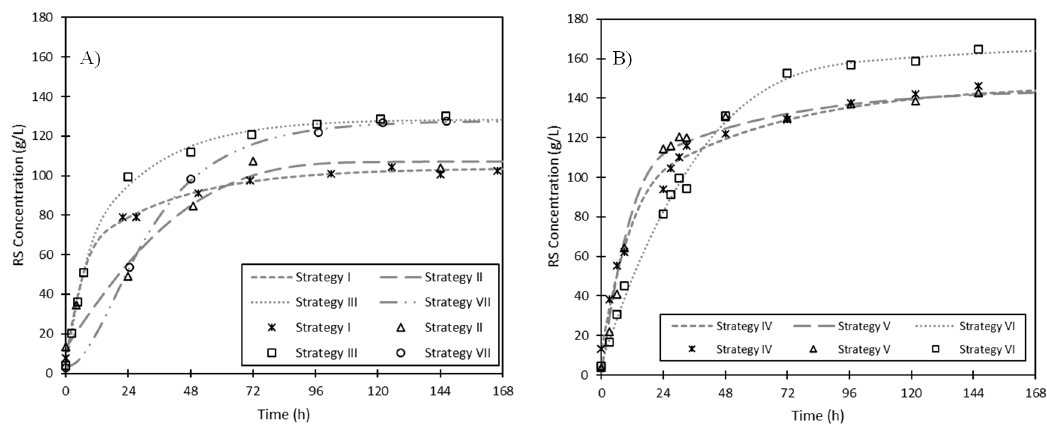
Figure 5. Evolution of RS concentration over hydrolysis time of fresh ESBPPs in 300 mL of citrate ‐ phosphate buffer (pH 5, 0.05 M) at 50 °C with addition of Celluclast ® (2.17 U ∙ g − 1 dried fresh ESBPPs). ( A ) Fed ‐ batch hydrolysis with a total FFR of 15:55. ( B ) Fed ‐ batch hydrolysis with a total FFR of 15:90. Lines indicate theoretical values obtained from the kinetic model and symbols represent experimental values. Table 5. Fed ‐ batch enzymatic hydrolysis strategies (I, II, III, IV, V, VI, VII) at 50 °C with addition of